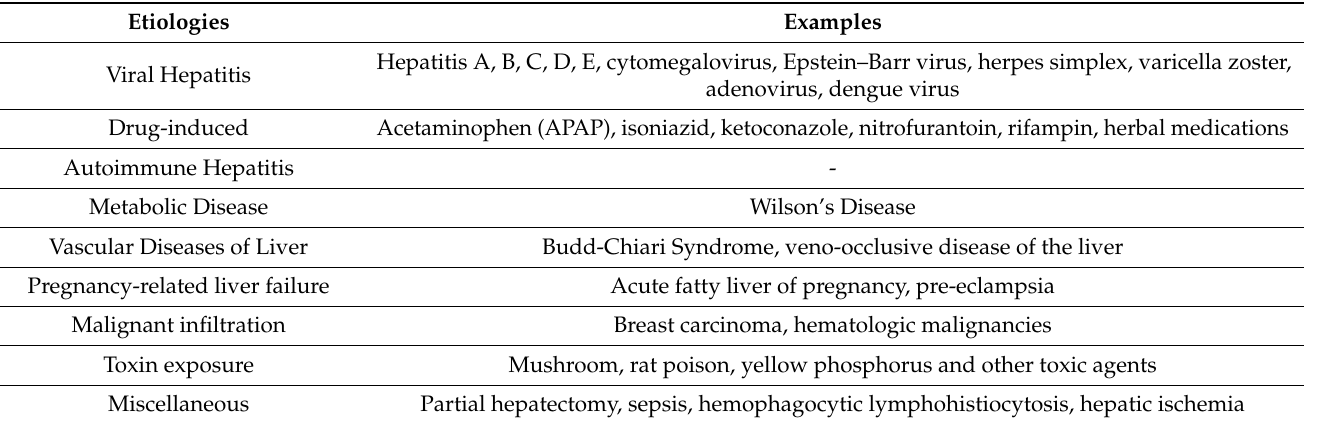
Table 1. Etiologies of acute liver failure [1,3].